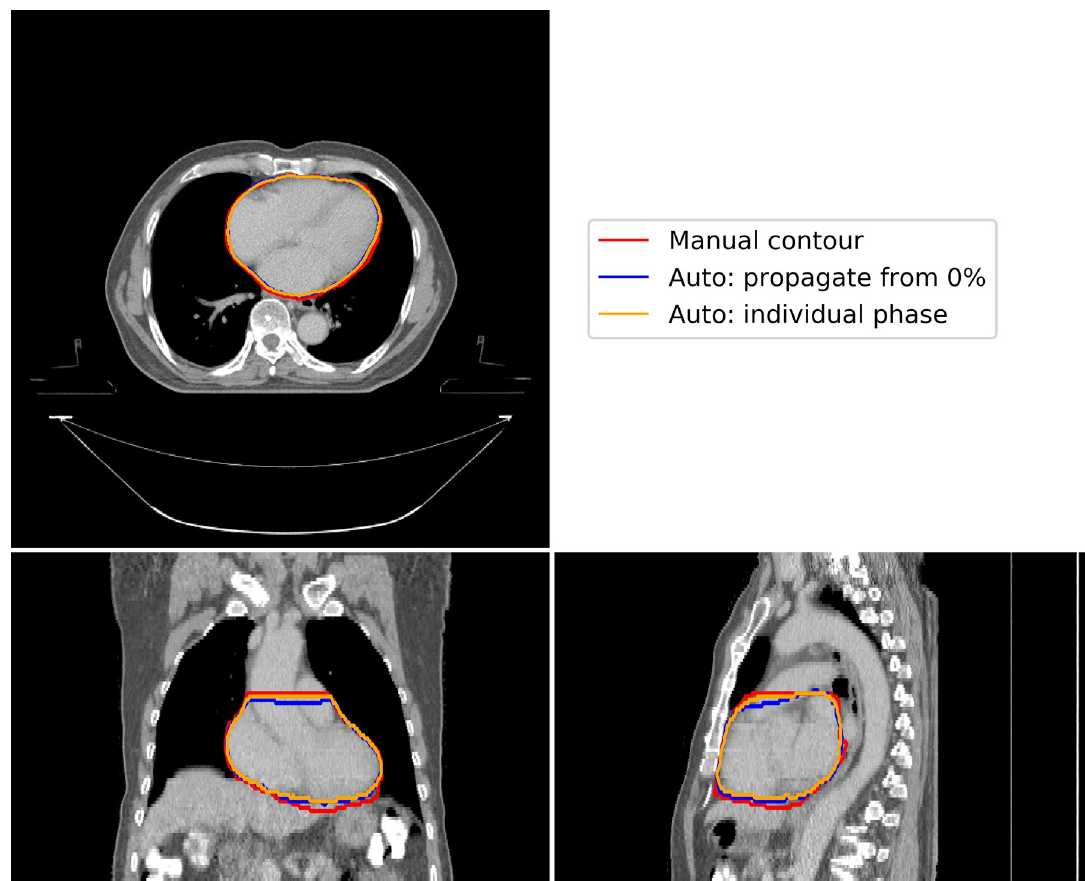
Fig 3. A representative example of the differences in automatic segmentation using our proposed method (blue contour), propagation of delineations from the 0% phase using deformable image registration, and independent automatic segmentation for each individual phase (orange contour), compared to manual contouring (blue contour). This figure illustrates results for the 40% phase image, where maximum deviation would be expected. There are minor variations at the base and apex of the heart.